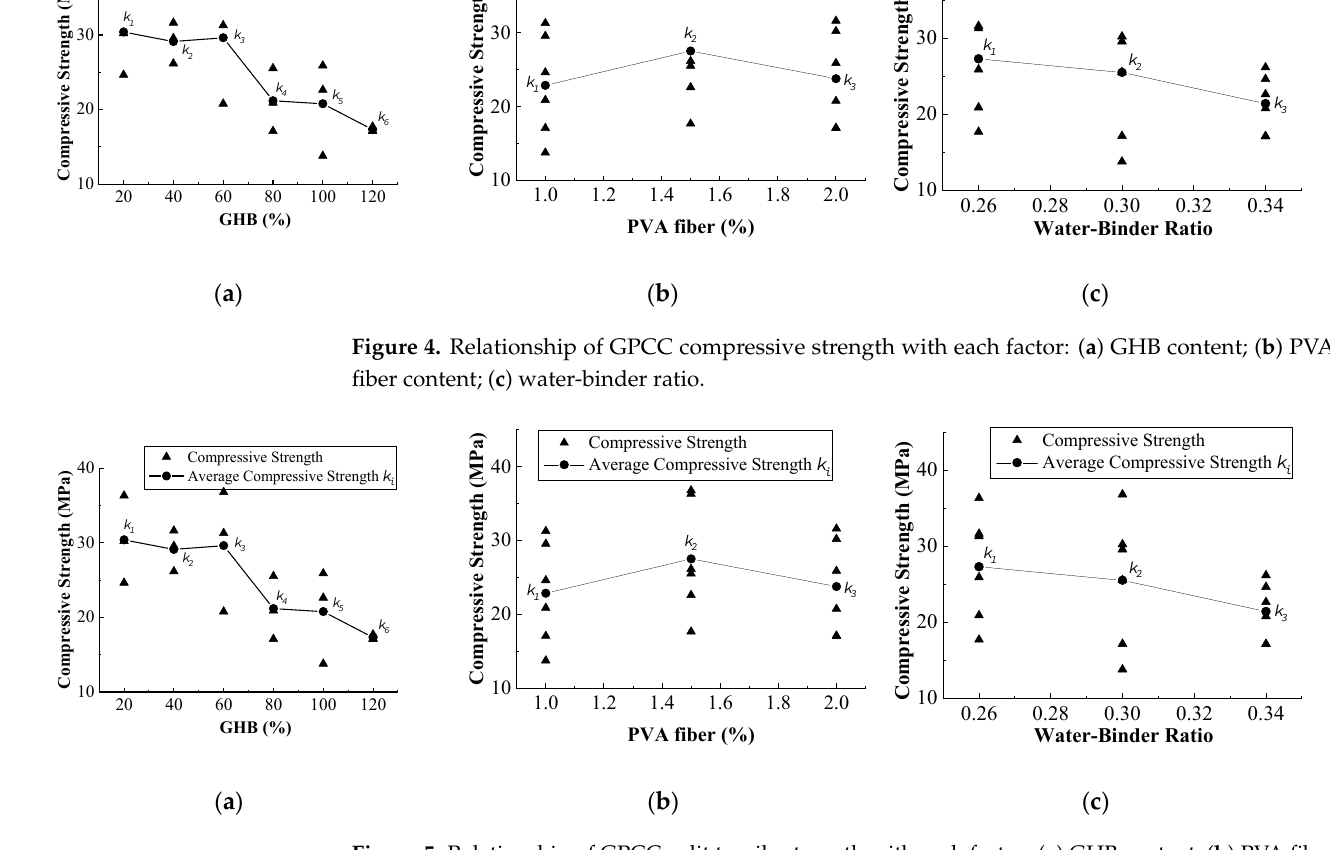
Figure 5. Relationship of GPCC split tensile strength with each factor: ( a ) GHB content; ( b ) PVA fiber content; ( c ) water-binder ratio.